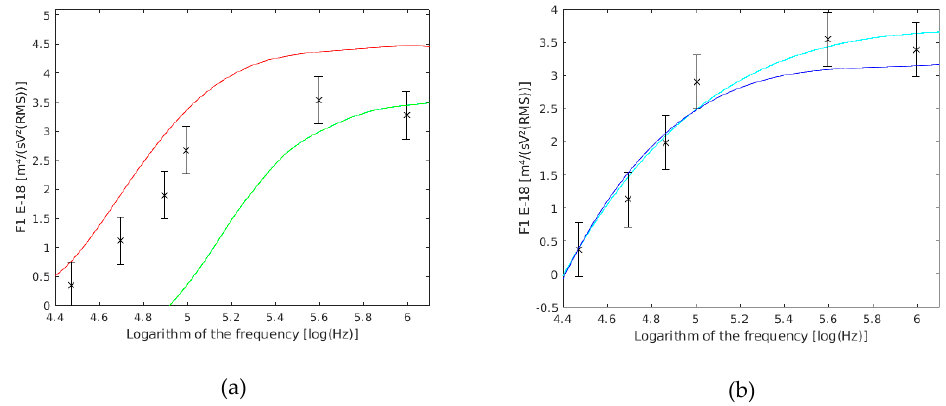
Figure 9. ( a ) F 1 variation with the cell wall conductivity ( σ p ). F 1 with a 11 mS / m cell wall conductivity are shown in red, those with a 0.11 mS / m cell wall conductivity are shown in green, and the results of this work are the six frequency points with their confidence intervals drawn. ( b ) F 1 variation with the cell wall relative permittivity ( ε ω ). F 1 with an 80 cell wall relative permittivity are shown in cyan, those with a 40 cell wall relative permittivity are shown in blue, and the results of this work are the six frequency points with their confidence intervals drawn.